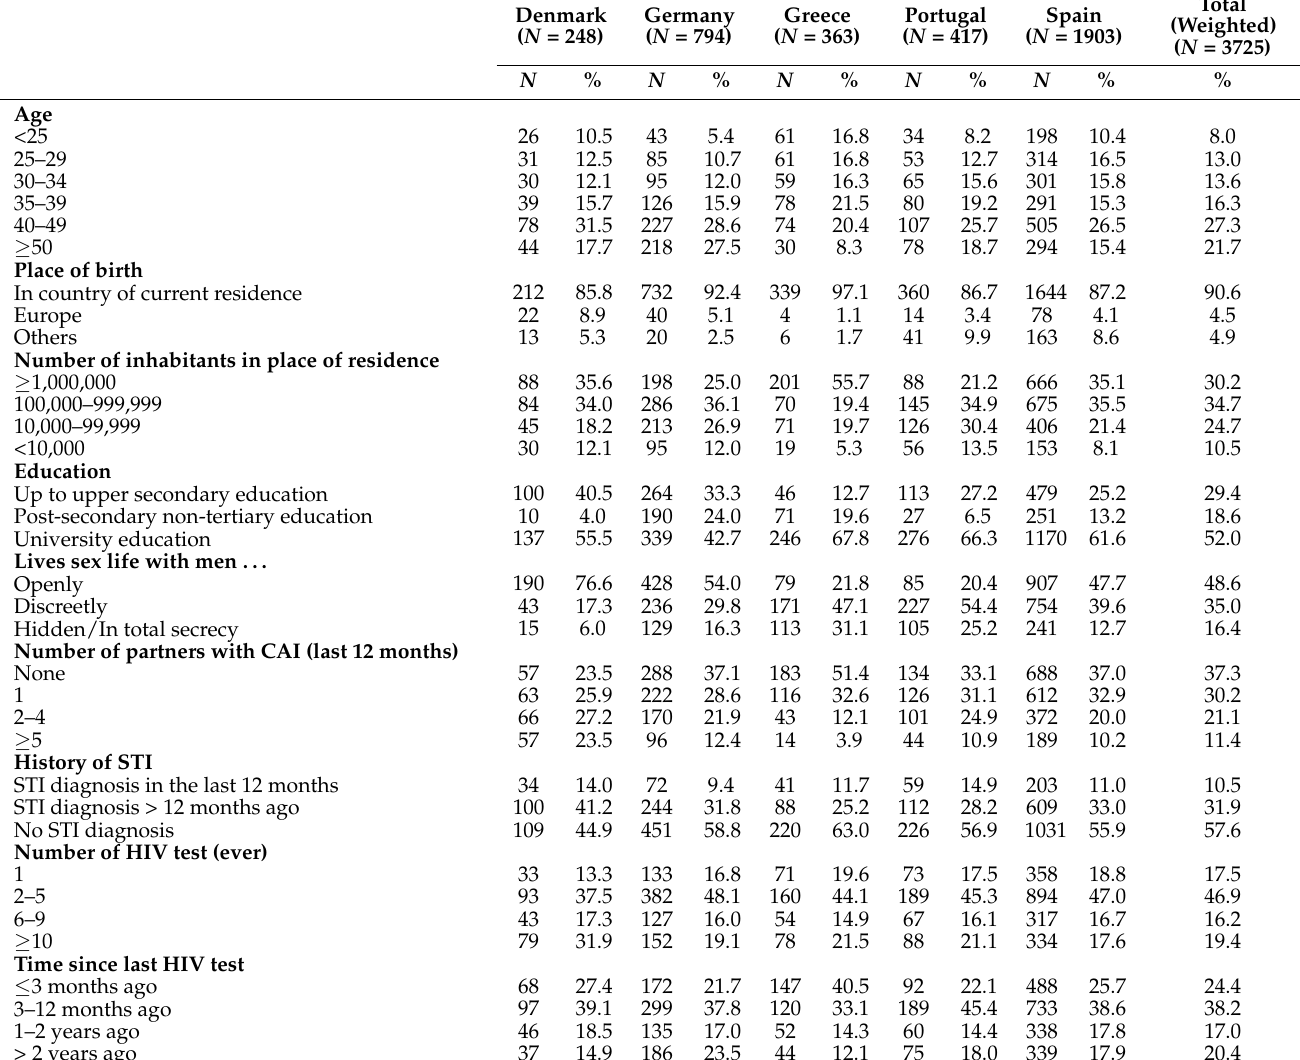
Table 1. Sociodemographic profile, outness, sexual behaviors, history of sexually transmitted infections (STI) and testing